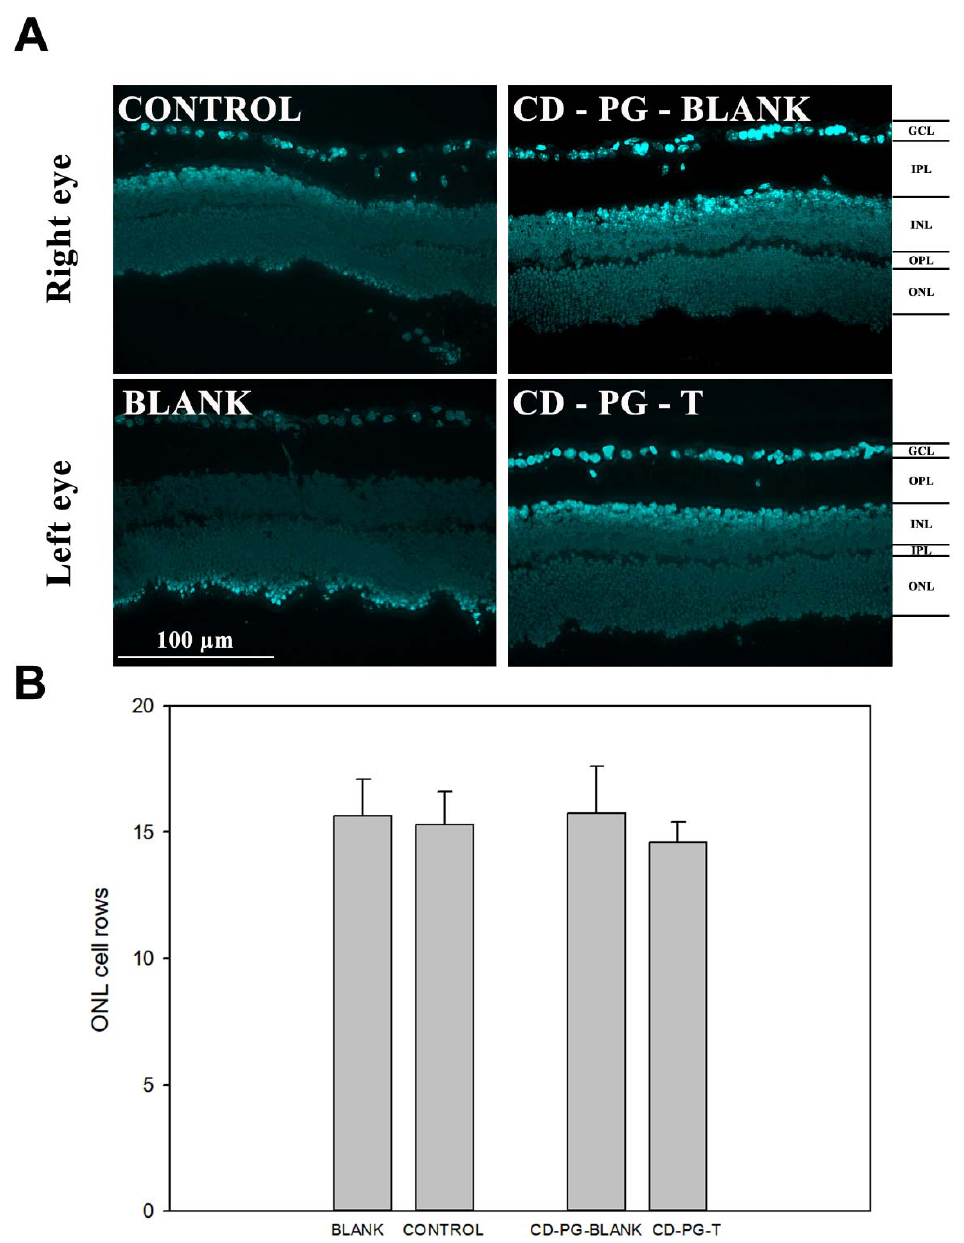
Figure 4. DAPI staining. ( A ) An example of DAPI staining for each experimental group. ( B ) Results of DAPI quantification in the outer nuclear layer (ONL). Table 1. Permeability values from original references ( a [16] and b [20]) and those recalculated using sink and non-sink